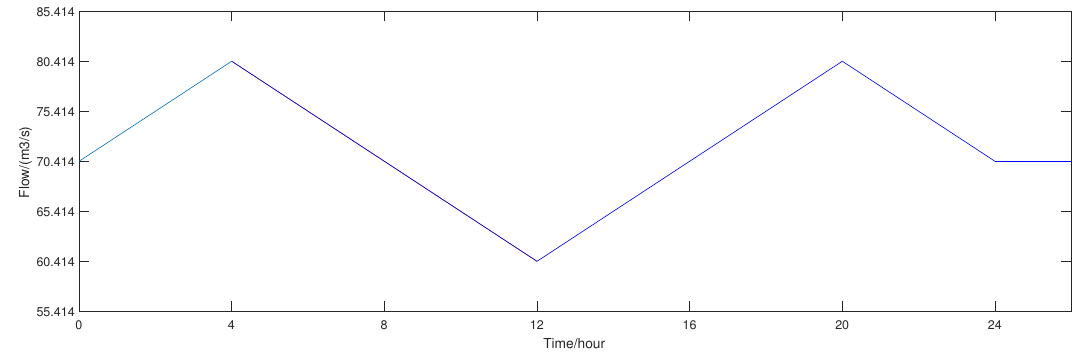
Figure 5. Flow rate changes of natural gas pipeline terminal